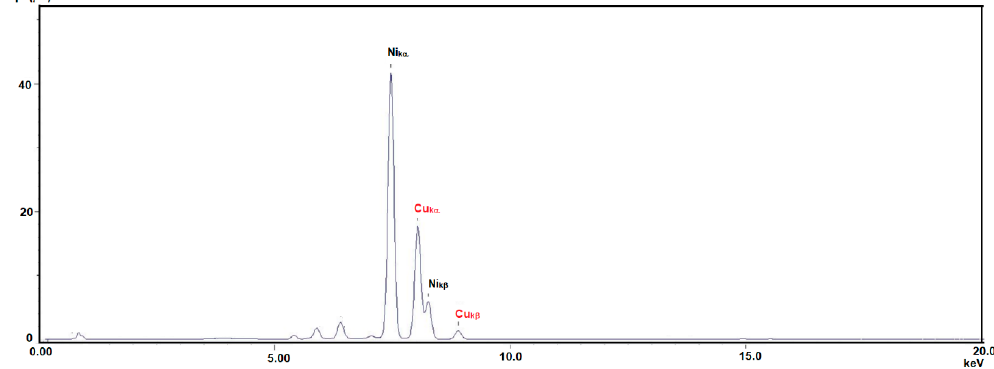
Figure 1. X-ray Flourescence ( XRF) of Monel alloy used in the experiments.